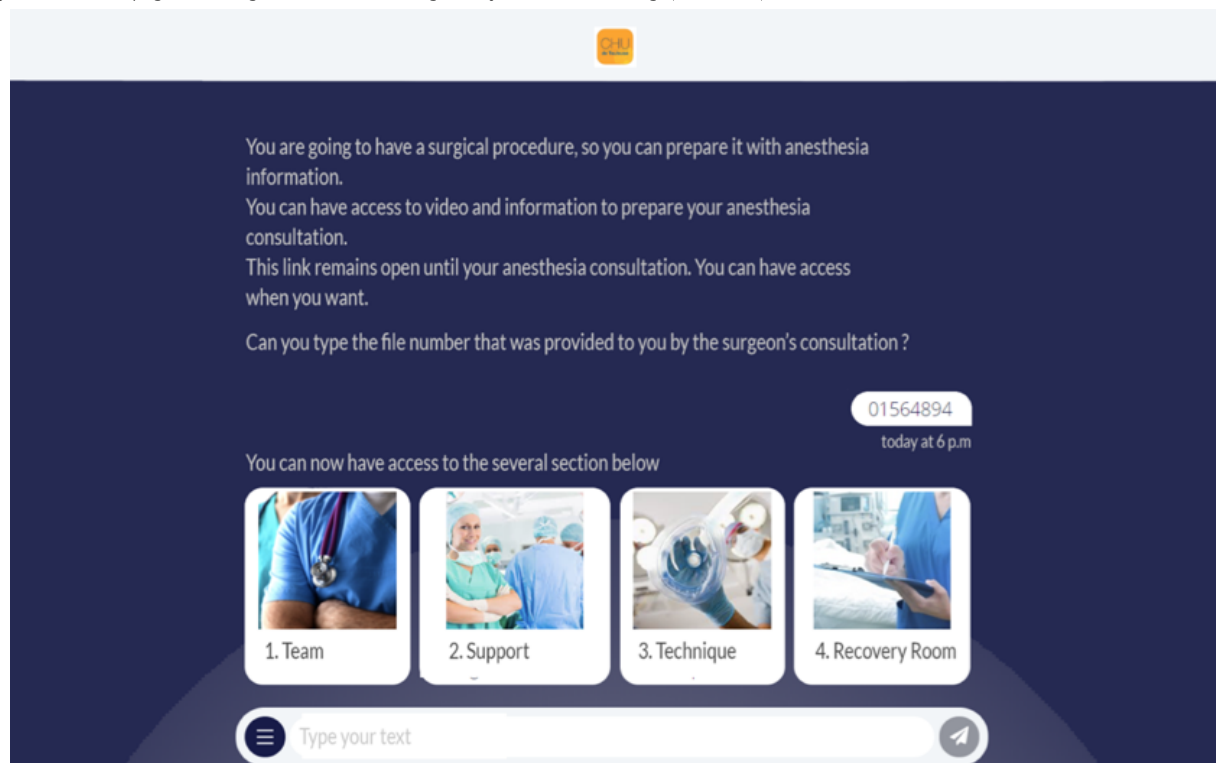
A version of the digital conversational agent, for demonstration purposes only, and identical to the one used in the study, is accessible online